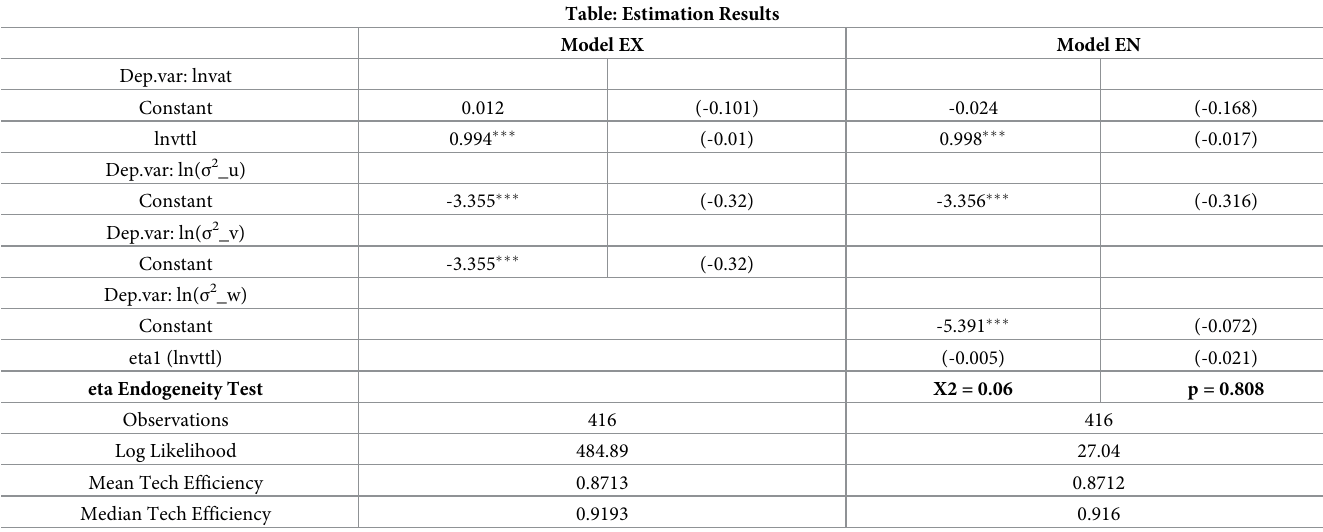
Table 9. Endogeneity test for the input variable of the stochastic tax frontier model.